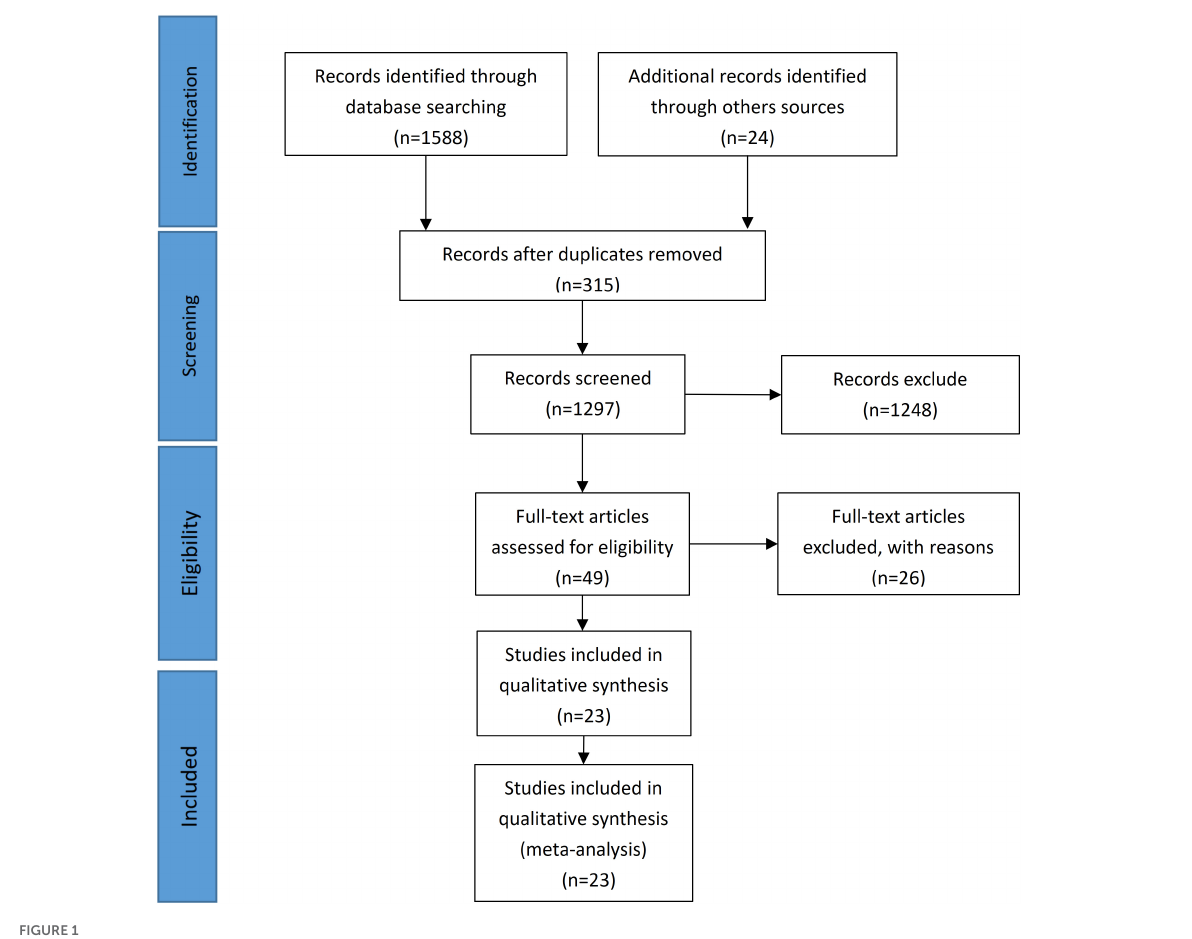
FIGURE1 PRISMA flow